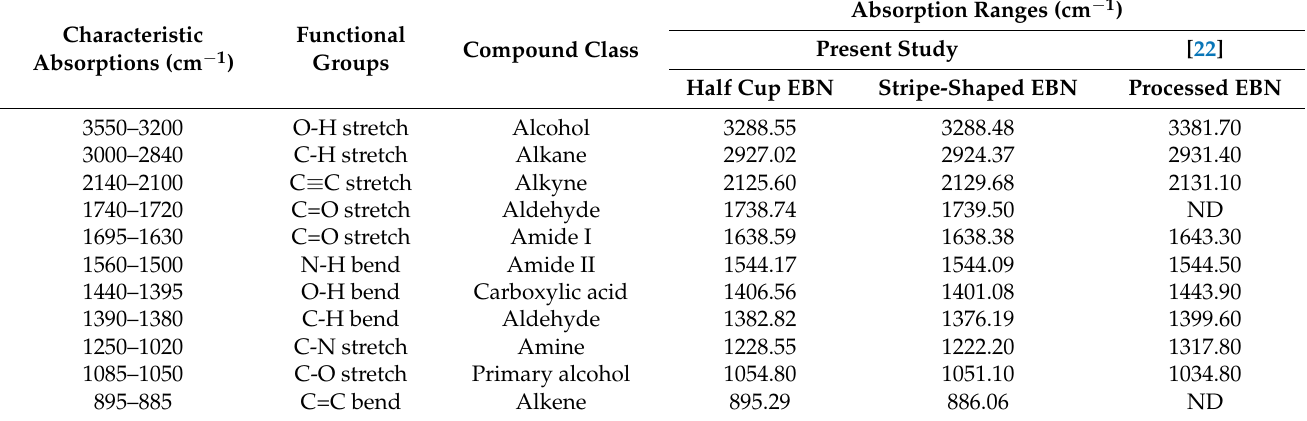
Table 1. Absorption range (cm − 1 ) and functional groups of the half cup and stripe-shaped EBN by FTIR. Characteristic Absorptions (cm − 1